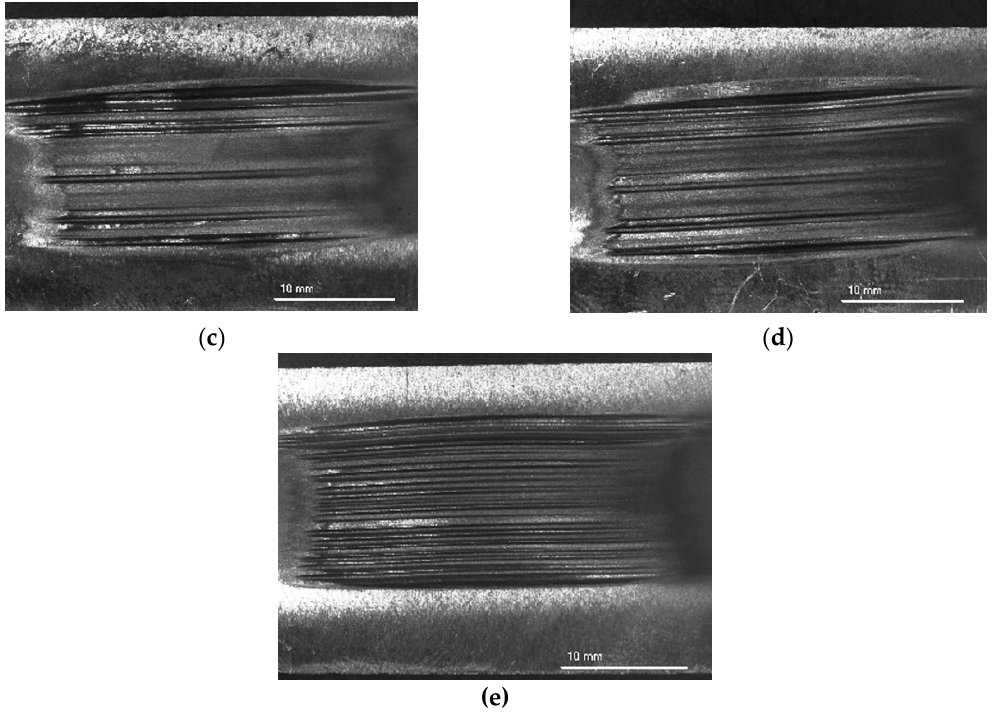
Figure 5. View of the specimen abrasion marks after the abrasive wear resistance test. O—Omnia Electrode; B—Barracuda Gold electrode; H—Hardox 450 steel; W—welding underwater; A—welding in the air; ( a ) OW1; ( b ) OA1; ( c ) BW1; ( d ) BA1; ( e ) H1.